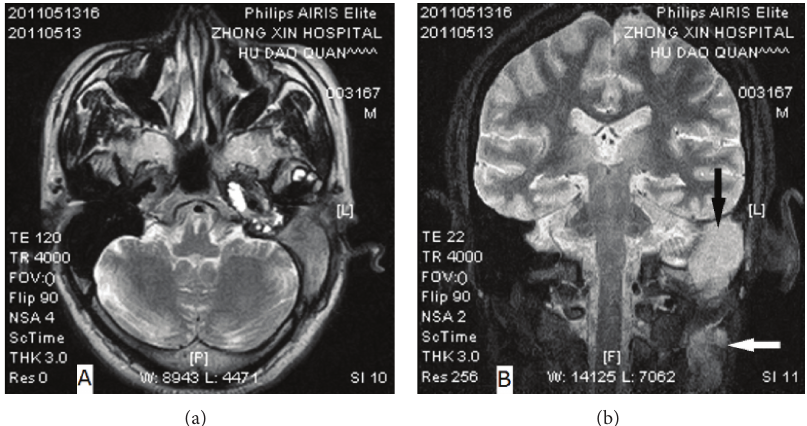
F 3: MR images of Case 2. (a) T2-weighted axial image shows a hypointensity lesion in the le mastoid; (b) PDW coronal image demonstratestwononhomogenousandslightlyhigh-signal-intensitymassinthelemastoid(blackarrow)andipsilateralneck(whitearrow),